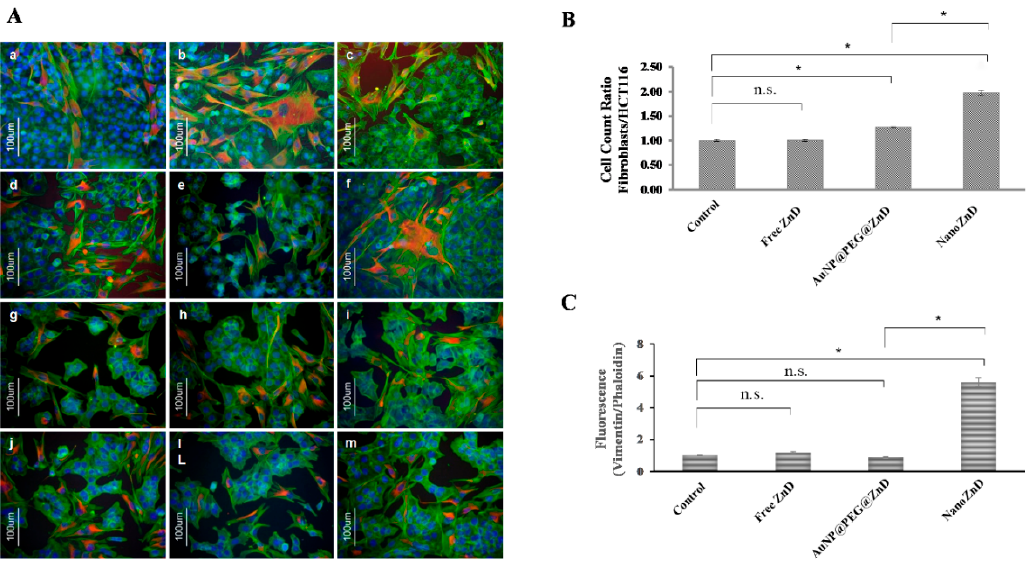
Figure 6. ( A ) Immunofluorescent images of the HCT116 and fibroblasts primary cell co-culture (vimentin stained in red). Co-cultures were incubated with fresh growth medium ( a – c ), ZnD at its respective IC 50 at 48 h (Table 1) ( d – f ), AuNP@PEG@ZnD nanoconjugate ( g – i ) and NanoZnD ( j , l , m ) Imaging Microscope and a Nikon DXM1200F digital camera. ( B ) Ratio Fibroblasts / HCT116. Cell